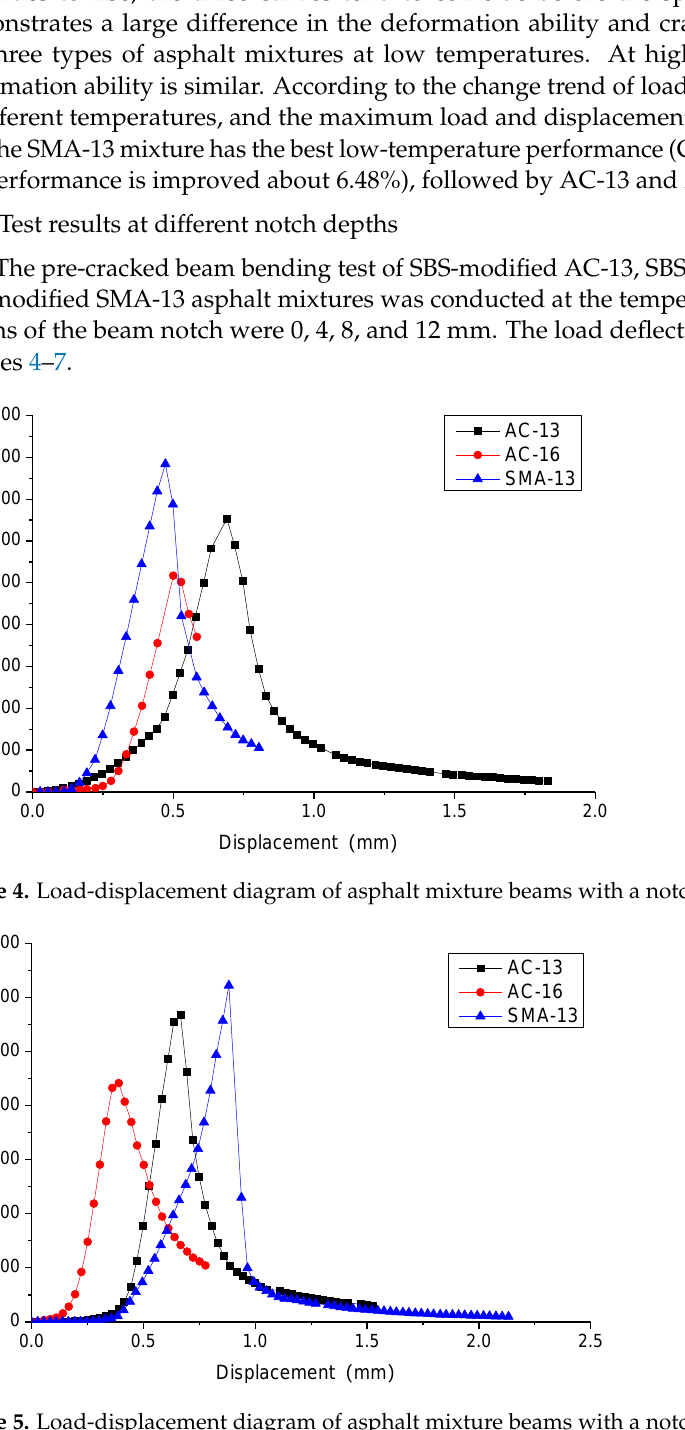
Figure 6. Load-displacement diagram of asphalt mixture beams with a notch depth of 8 mm.